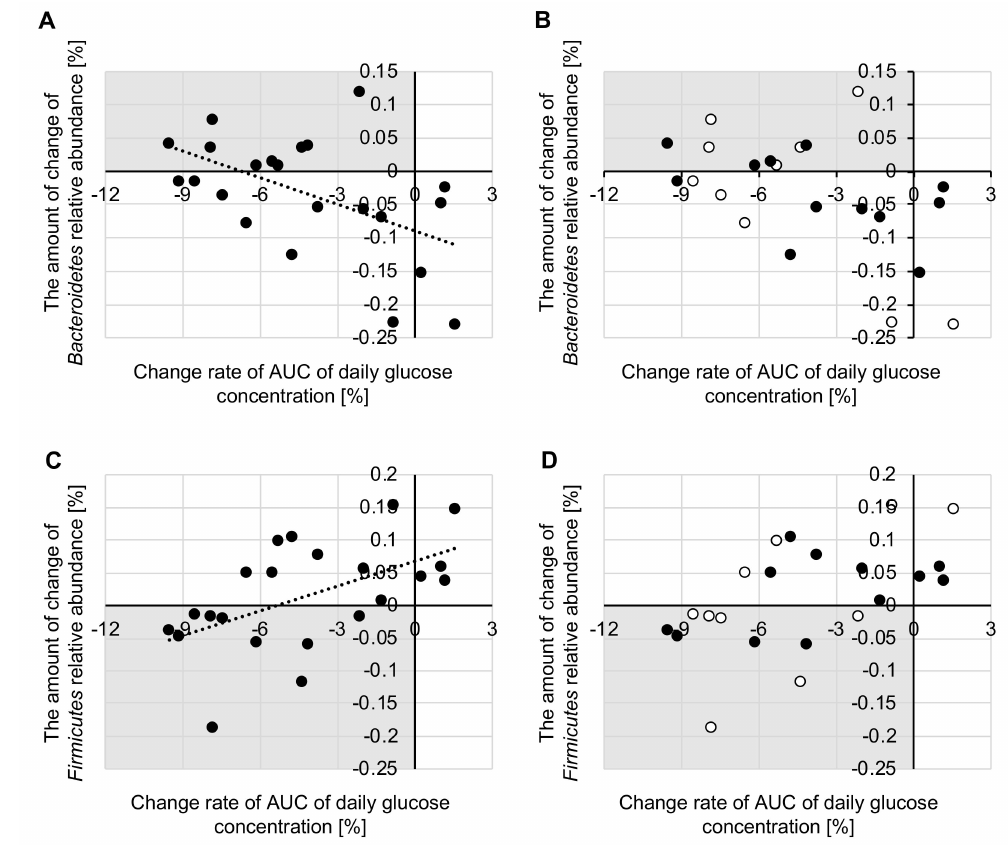
Figure 6. Correlation between the change rate of the area under the curve (AUC) for the diurnal glucose concentration and the amount of change of ( A , B ) phylum Bacteroidetes ( C , D ) relative abundance and Phylum Firmicutes ( n = 22). The white plot indicates the morning group ( B , D ). The black plot indicates the evening group ( B , D ). ( A ) and ( C ) are the correlations for all participants. ( B ) and ( D ) are the correlations between each